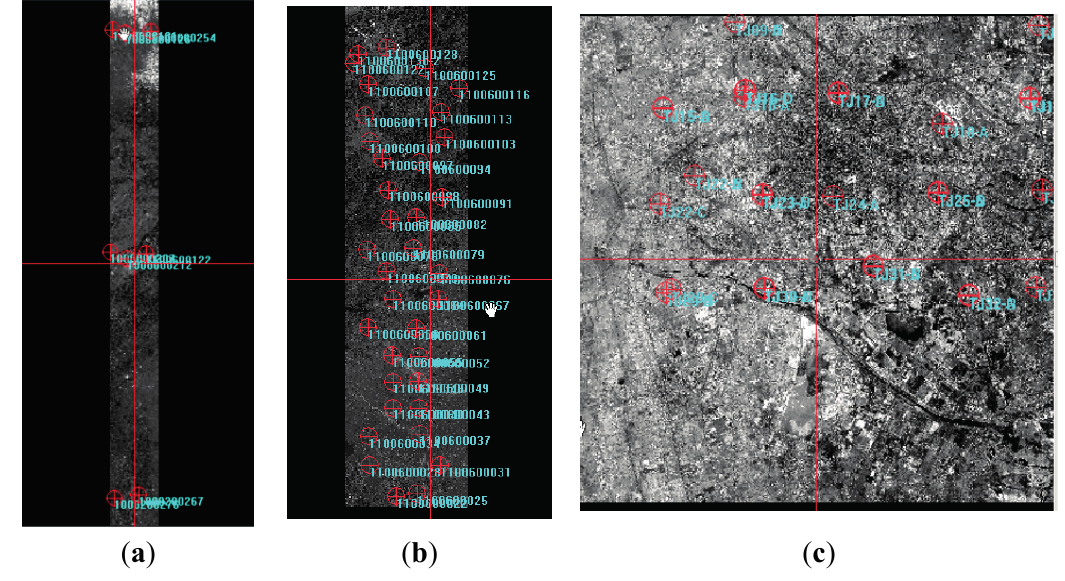
Figure 4. The distribution of GCPs in Test sites (nadir-view). ( a ) Taiyuan site (381th track);